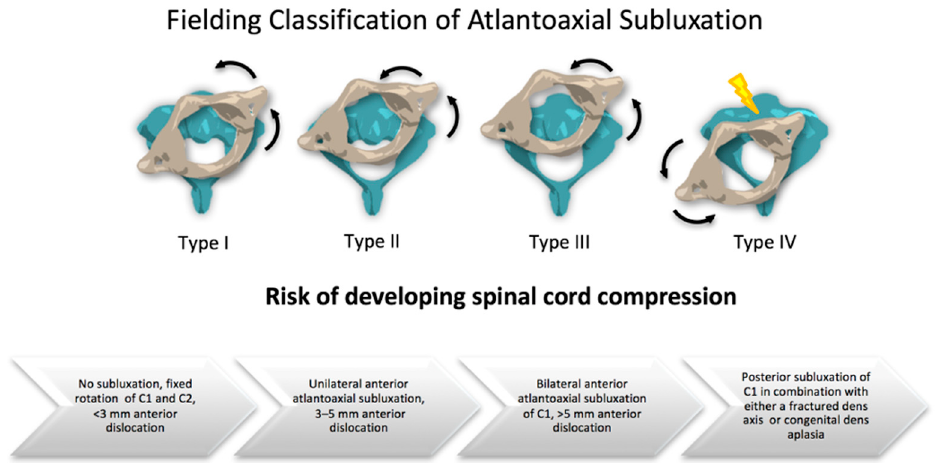
Figure 1. Fielding Classification of Atlantoaxial Subluxation (AAS) [17].